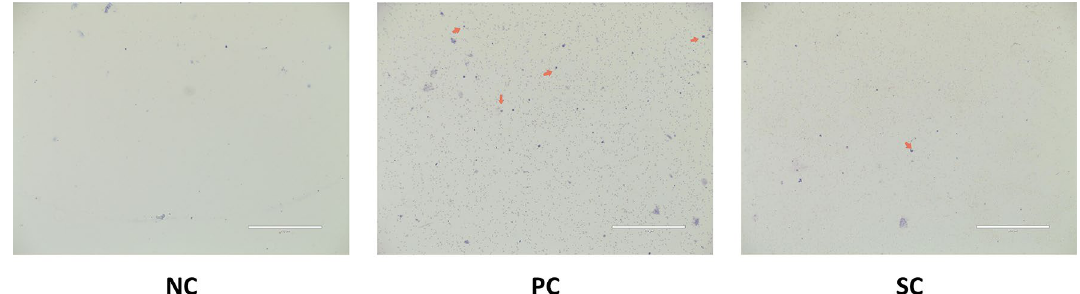
Figure 3. Diff-Quik was used to detect the infiltration of inflammatory cells in nasal lavage fluid (the orange arrows indicate